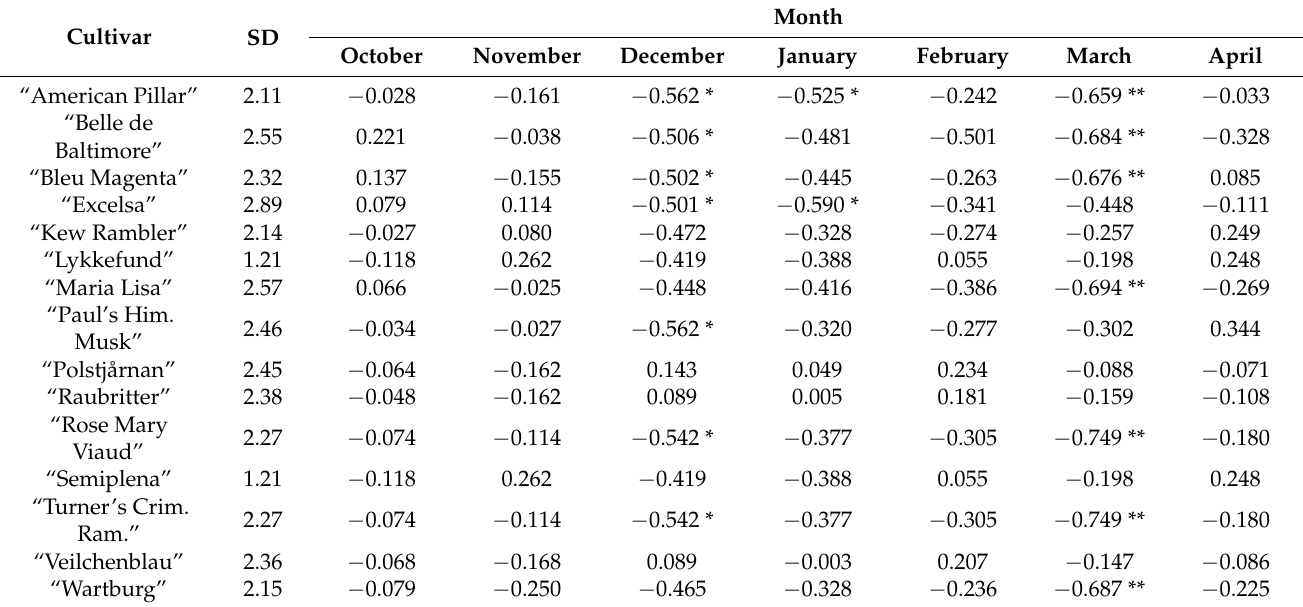
Table 3. Part of matrices concerning effect correlations between minimum monthly air temperatures (2005/2006, 2009/2010, and 2015/2016) and frost damage of rambler